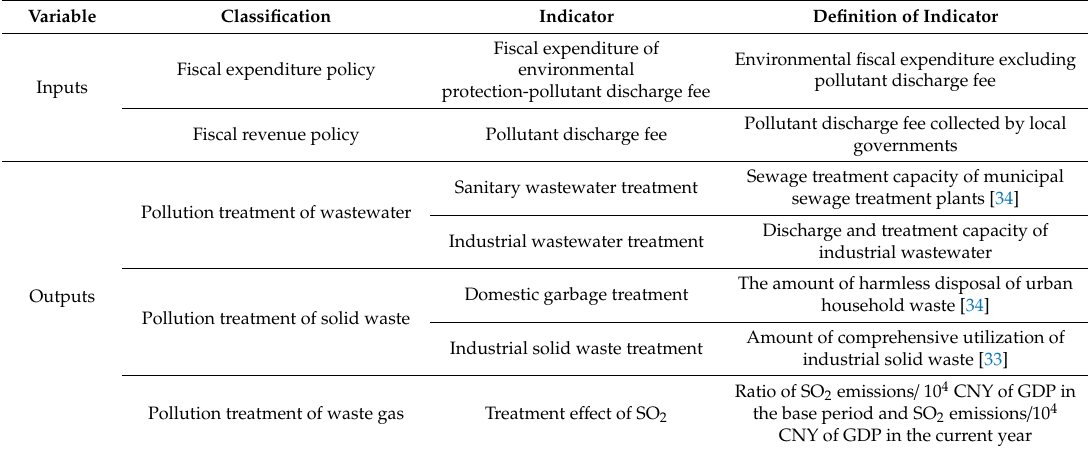
Table 1. Indicators of input and output in the e ffi ciency measurement of fiscal policies for environmental pollution